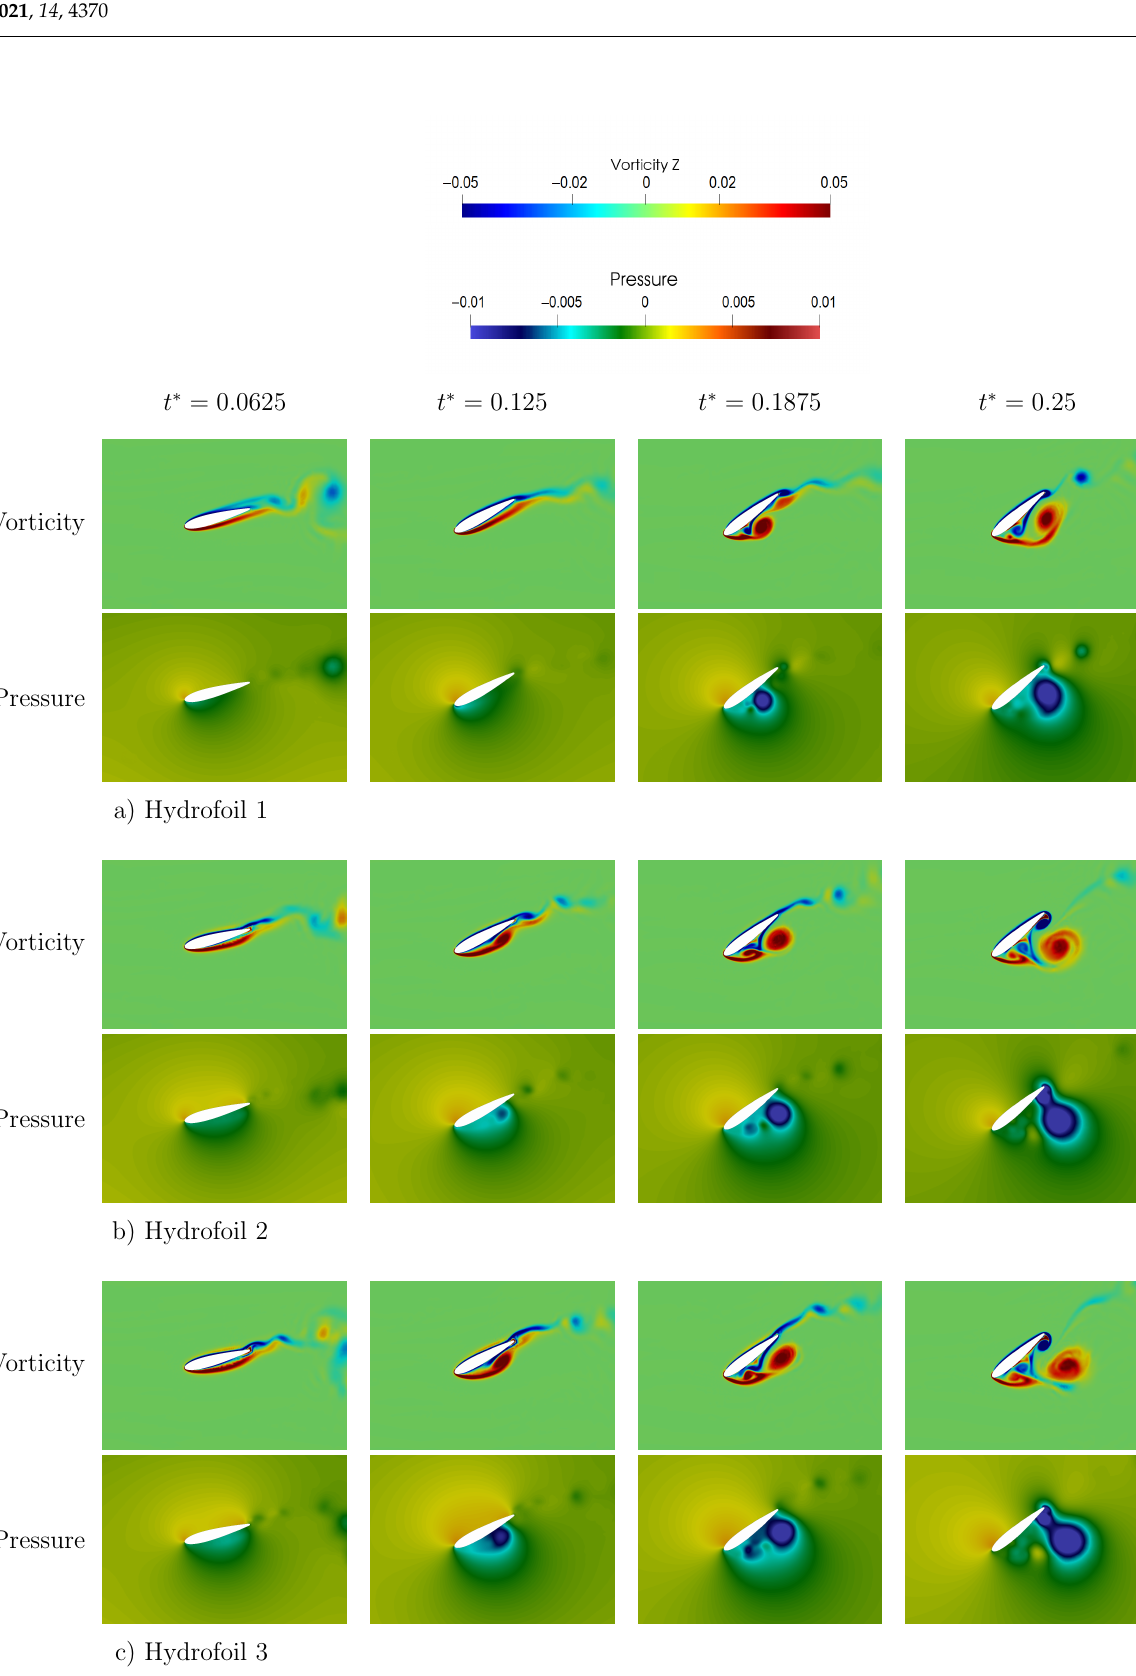
Figure 11. Vorticity and pressure fields around the oscillating hydrofoils (1–3) for α 0 = 40 ◦ , f ∗ = 0.025, and ∆ h = 0.8 m, at times t ∗ = 0.0625, 0.125, 0.1875, and